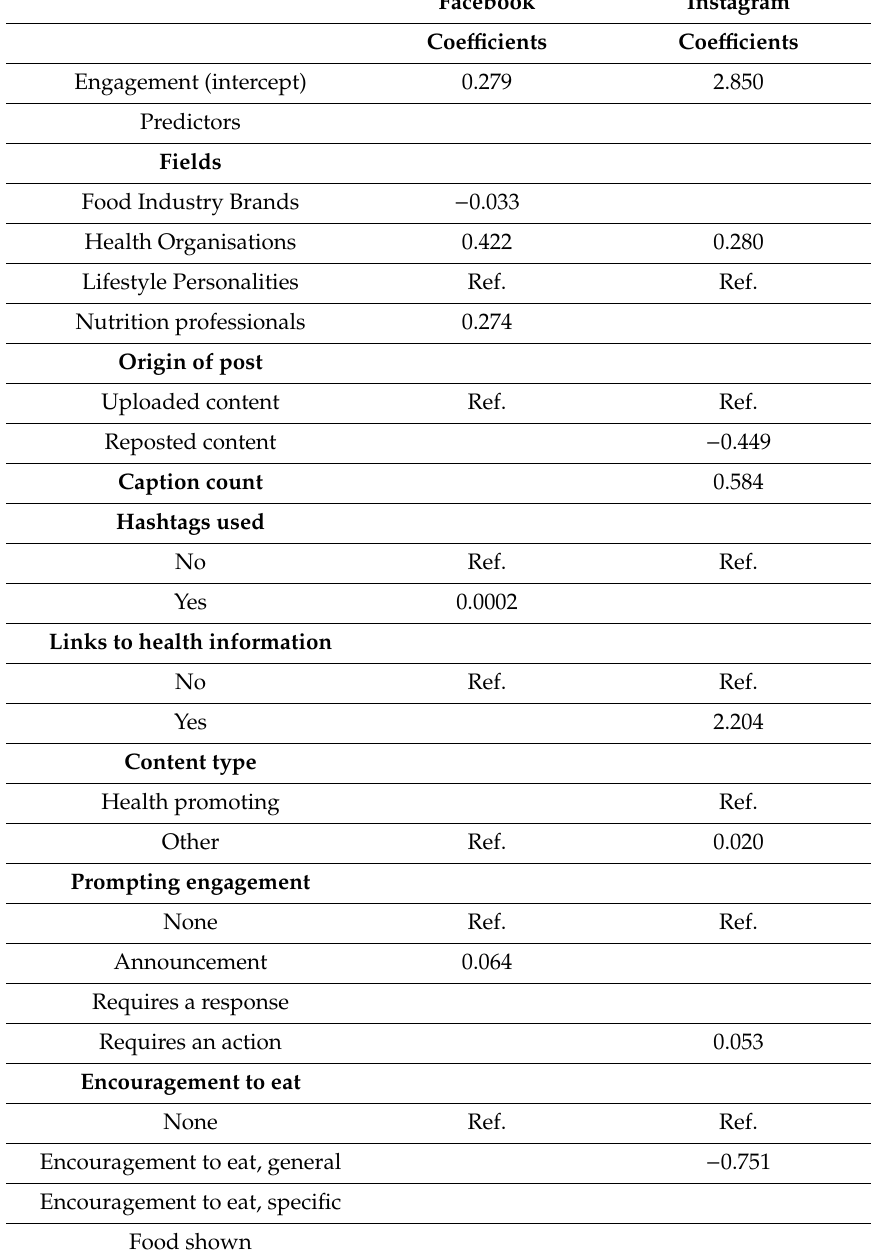
Table 2. Least Absolute Shrinkage and Selection Operator (LASSO) regression coe ffi